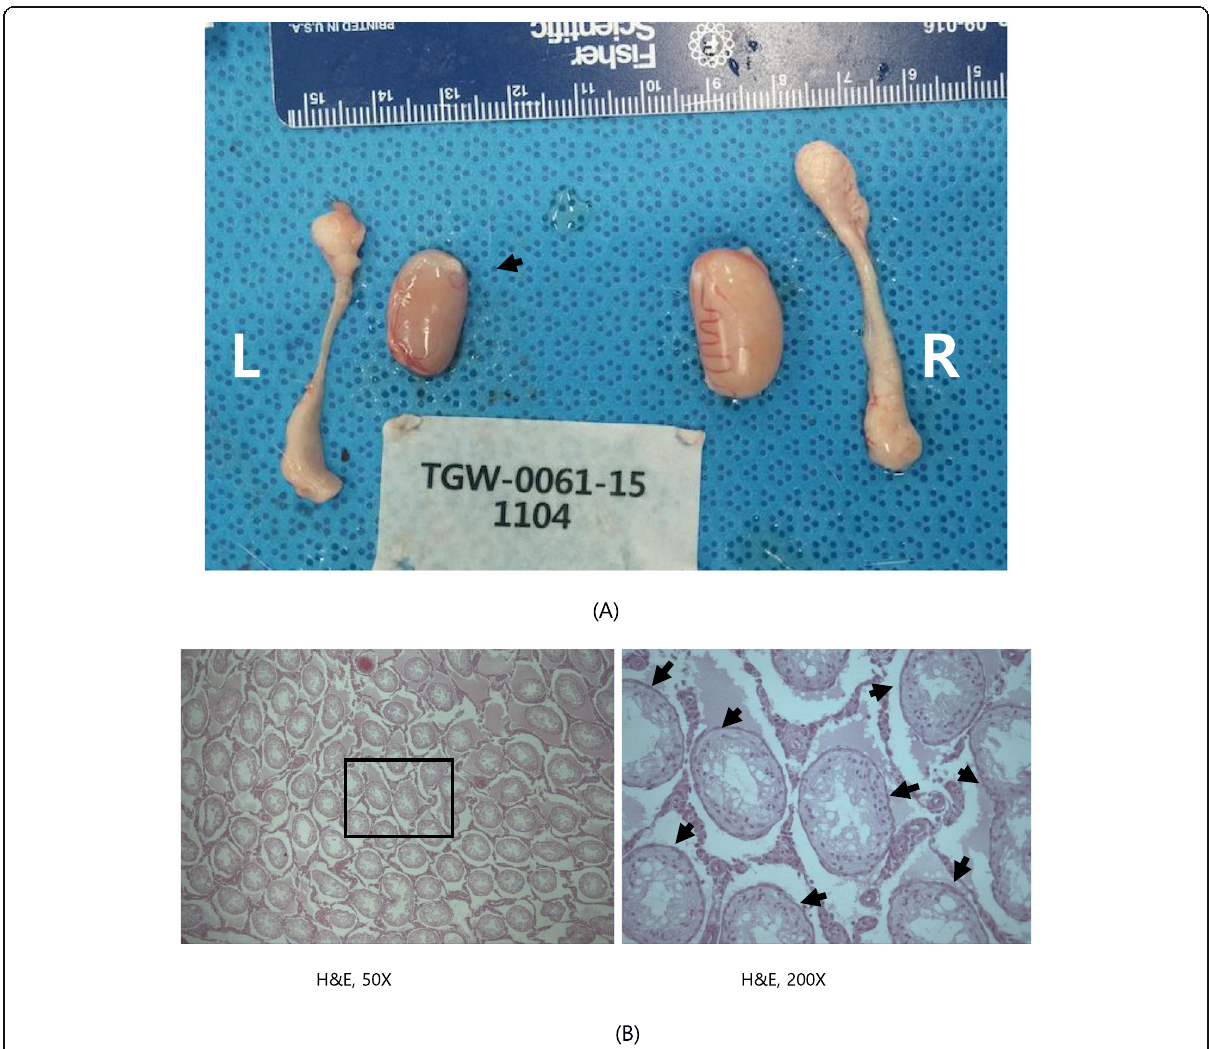
Fig. 4 Reduced left testis in male G1 (control group; rat number 1104) ( a ) Necropsy finding, ( b ) Tubular atrophy; H&E 50X,